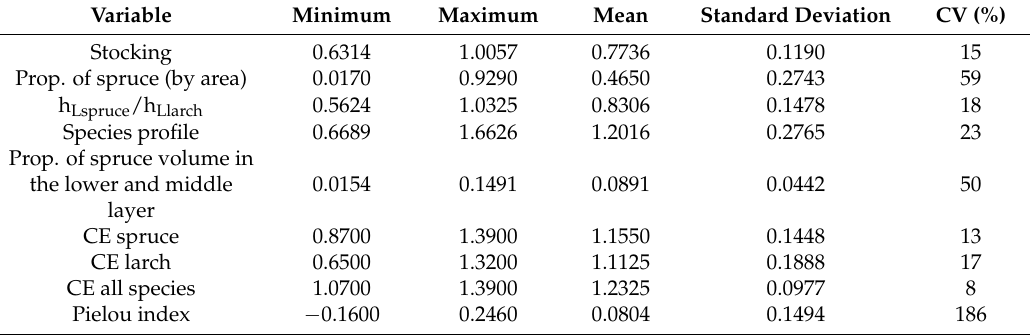
Table 3. The distribution of the structural variables in the 12 plots. Stocking and the proportion of spruce are defined above. h Lspruce /h Llarch is the ratio between Lorey’s mean height of spruce and larch. CE is the Clark Evans index. Please note that when there are only two species in a stand, the Pielou index for both species is the